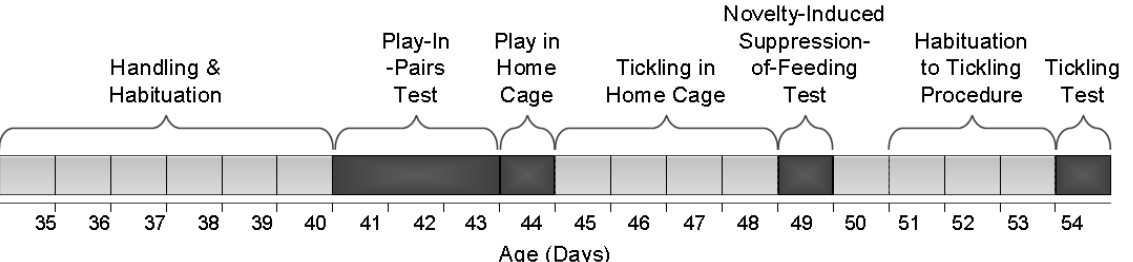
Figure 1. Experimental